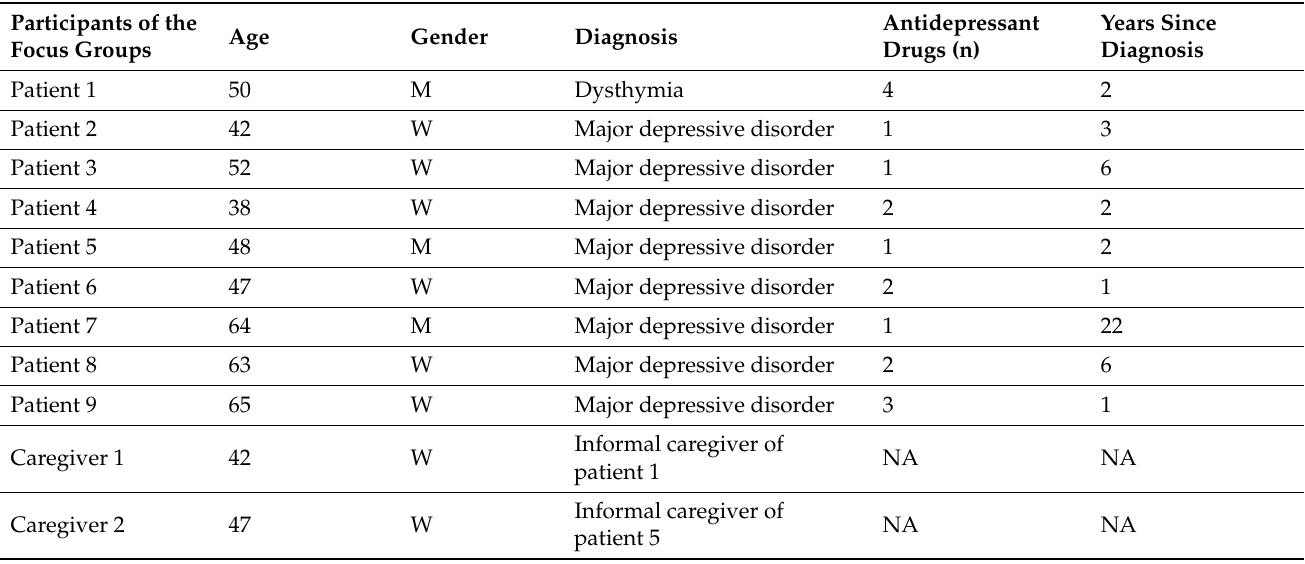
Table 2. Individual characteristics of participants of focus group (patients and